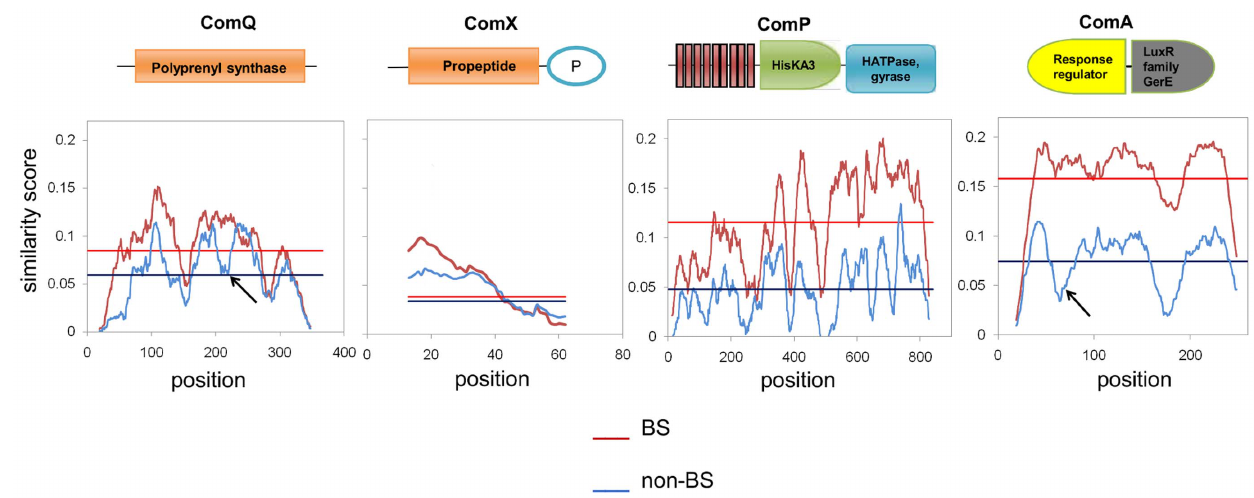
Figure 5. Variability of Com protein sequences in the B.subtilis -like (red) and non- B.subtilis -like (blue) proteins. The average variability of the two clades is plotted for each protein respectively [32], the straight lines represent the average value of the plots. Note that the overall course of the variability is similar in both clades, i.e. peaks and valley are at the same position, and the non- B. subtilis -like group are more variable than the B. subtilis -like proteins. A conspicuous difference between the two clades is found in ComA protein where the response regulator domain in the non- B. subtilis -like clade has a variable region (valley indicated by arrow).